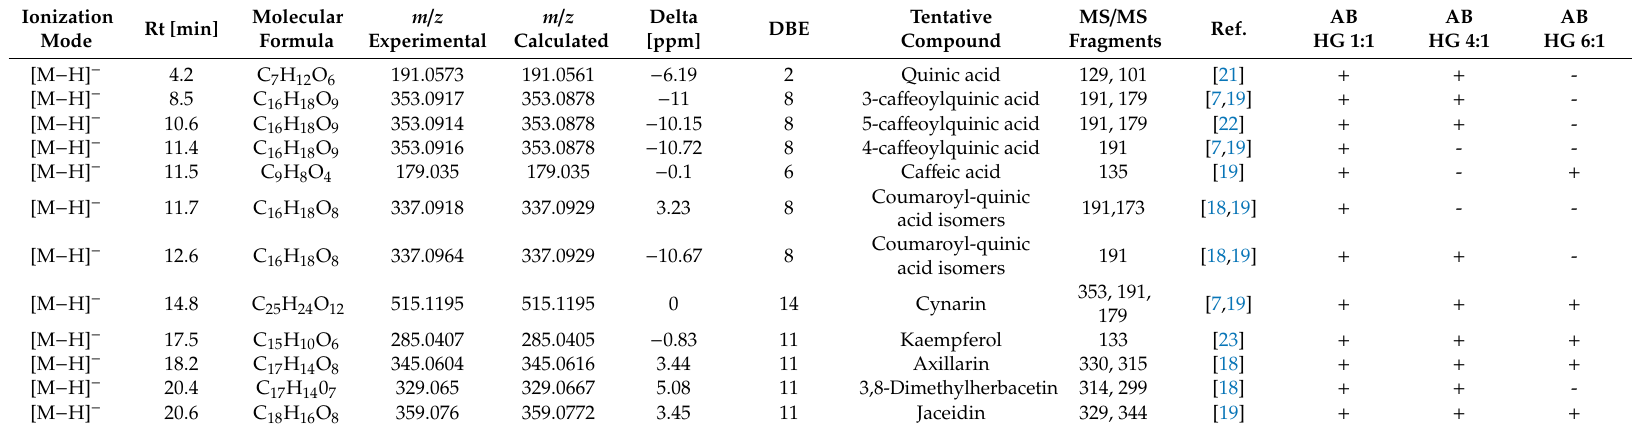
Table 1. The tentatively identified compounds in Achillea biebersteinii extracts.